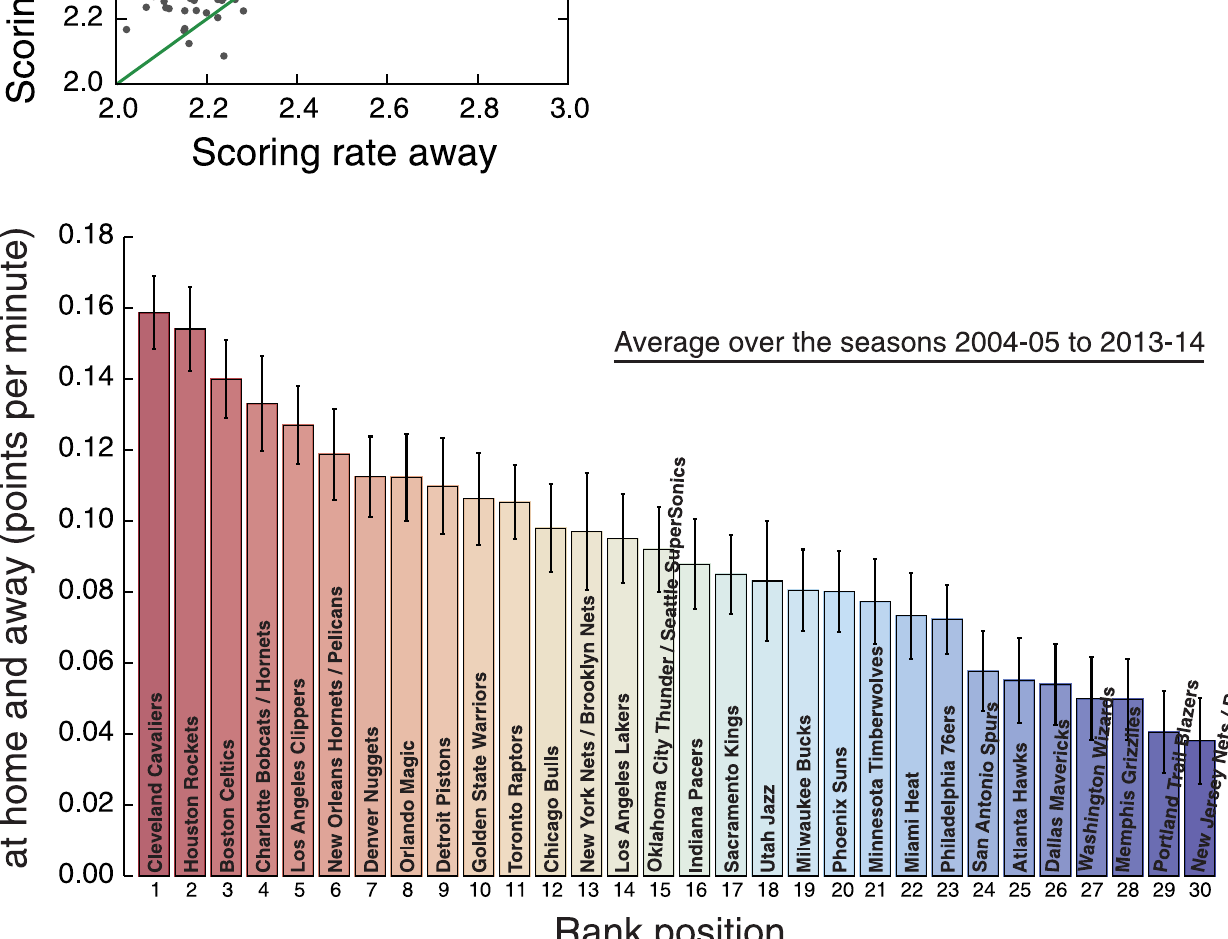
Fig 4. Ranking NBA teams according to the difference between the scoring rate at home and away. (A) Scoring rate at home versus scoring rate away (that is, the values of R ). The dots represent the scoring rates (at home and away) for every team and NBA season, and the green line is a linear function (with a unitary linear coefficient and a zero intercept). Notice that there are only a few cases in which the scoring rate is larger when playing away than when playing home. (B) Average of the difference between the scoring rates at home and away for each NBA team (in descending order). These averages were calculated over the seasons 2004 – 05 to 2013 – 14 (during this period the teams were the same; see and S6 Fig for all scoring rates) and the error bars are 95% bootstrap confidence